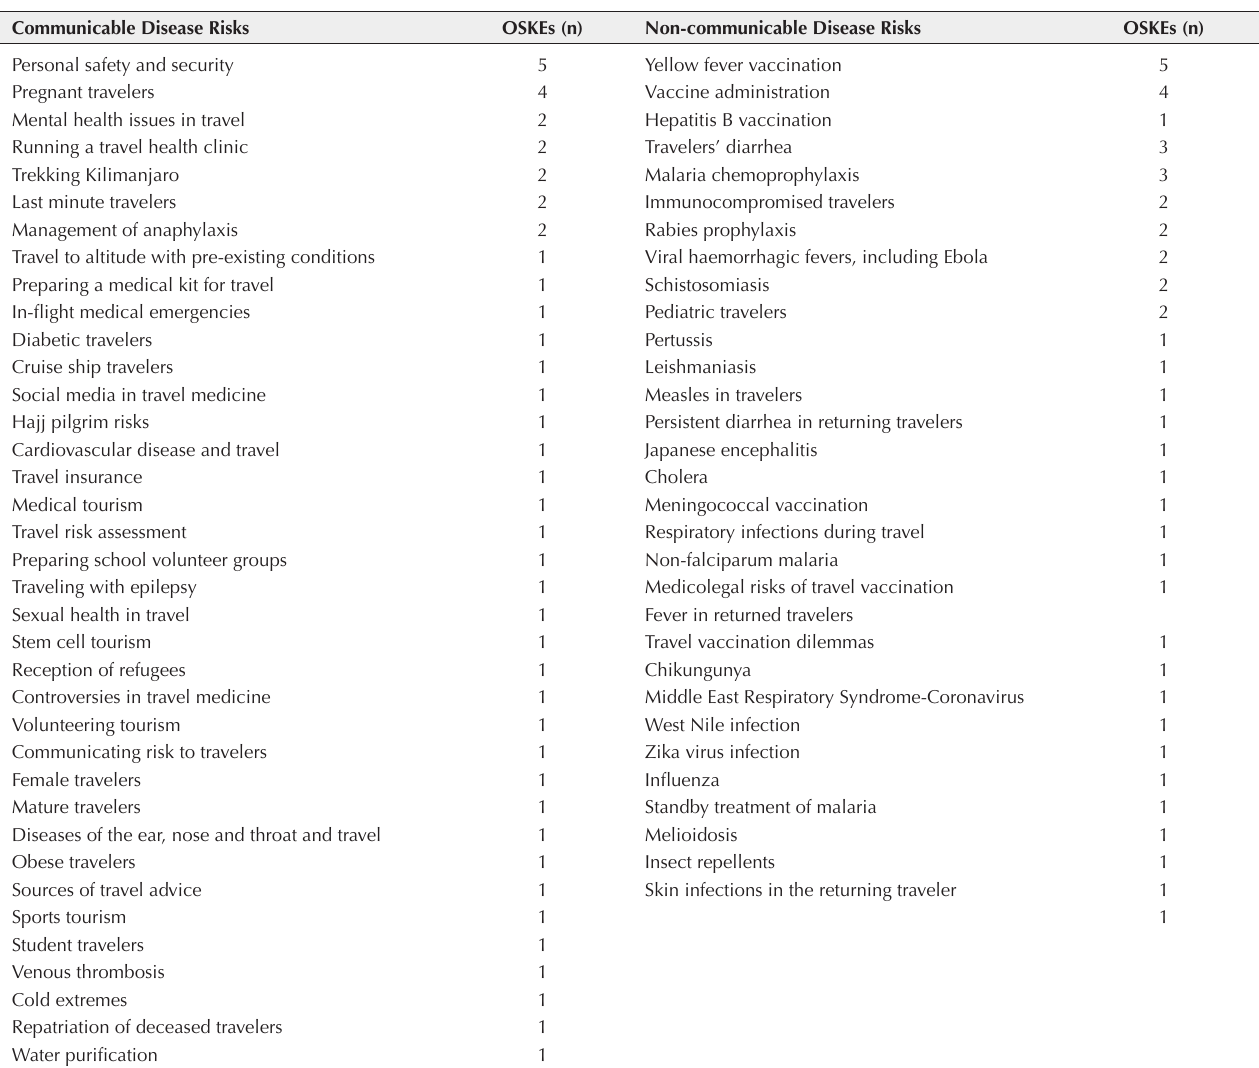
Table 1. Coverage of OSKE Subjects in TMSI Educational Seminars, 2012-2018 Communicable Disease